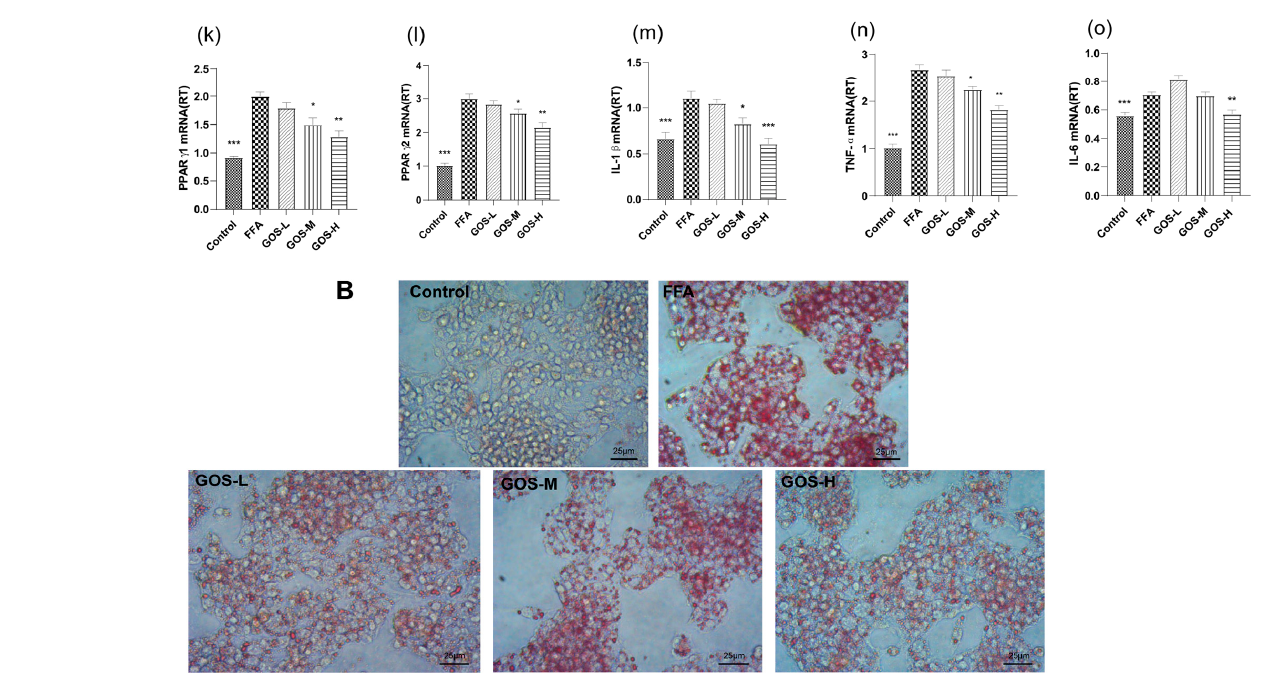
Figure 12. ( A ) ( a ) Cell survival rates under different GOS concentrations ( n = 6, mean ± SEM). ALT ( b ) and AST ( c ) contents in cell culture medium, intracellular TC ( d ) and TG ( e ) contents in each group after administration ( n = 6, mean ± SEM). Effects of GOS on the expression of FAS ( f ), SREBP-1c ( g ), ACC1 ( h ), PPAR α ( i ), SCD1 ( j ) PPAR γ 1 ( k ), PPAR γ 2, ( l ) IL-1 β ( m ), TNF- α ( n ), and IL-6 ( o ) genes in each group ( n = 6, mean ± SEM). Note: * p < 0.05, ** p < 0.01, *** p < 0.001 vs. the FFA group. ( B ) Oil red O staining of cells in each group (400×).